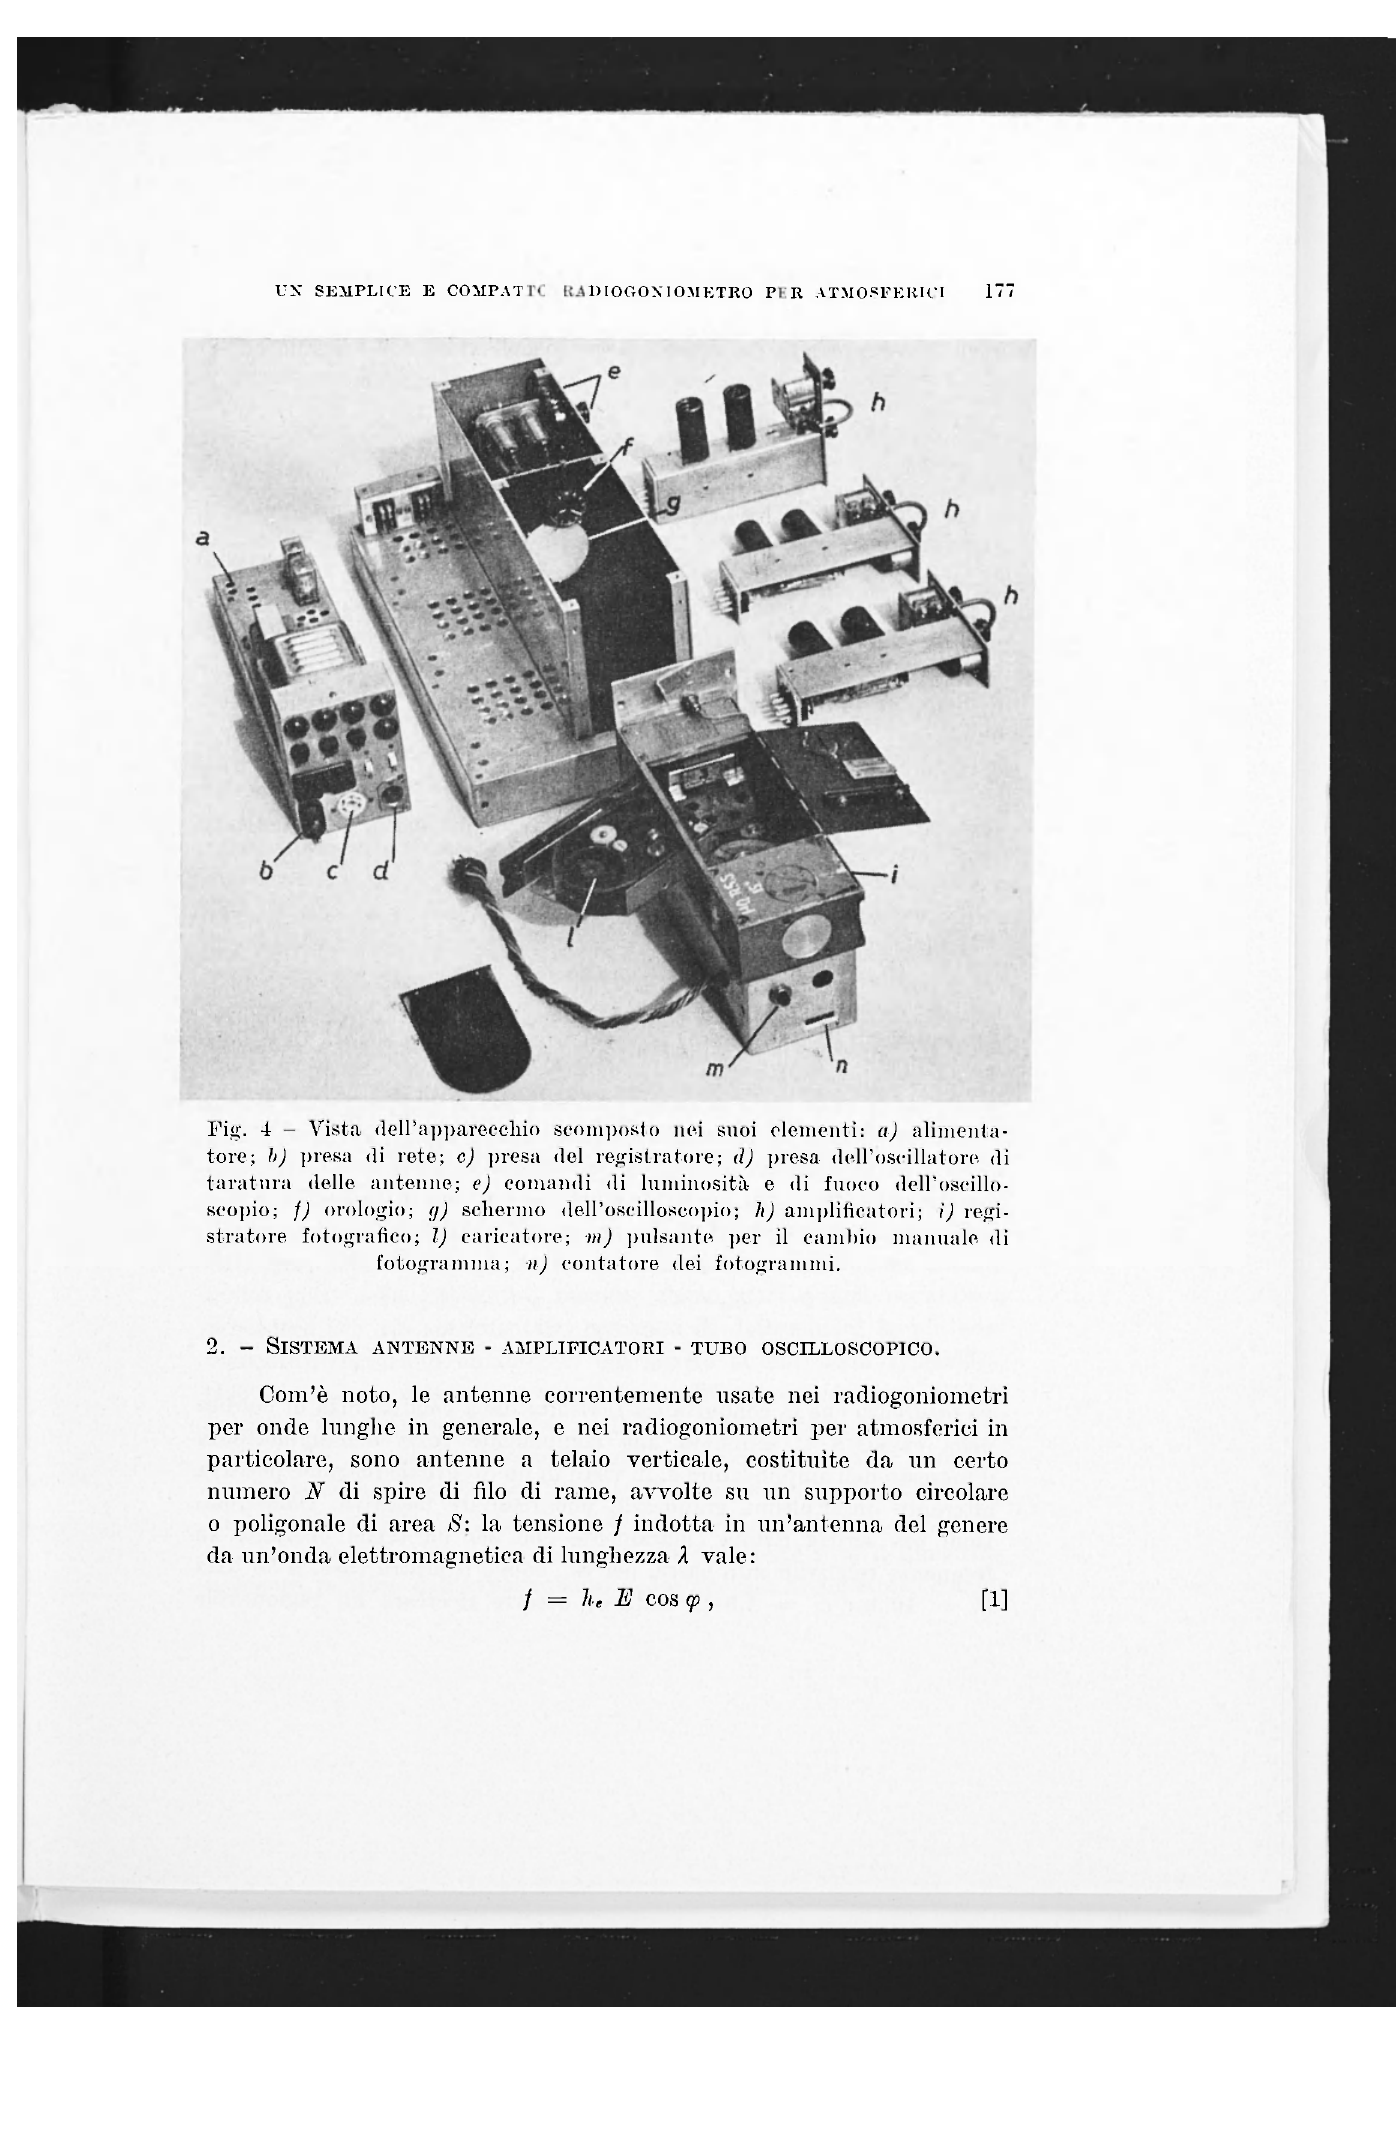
2. - SISTEMA ANTENNE - AMPLIFICATORI - TUBO OSCILLOSCOPICO. Com'è noto, le antenne correntemente usate nei radiogoniometri per onde lunghe in generale, e nei radiogoniometri per atmosferici in particolare, sono antenne a telaio verticale, costituite da un certo numero N di spire di filo di rame, avvolte su un supporto circolare o poligonale di area la tensione / indotta in un'antenna del genere da un'onda elettromagnetica di lunghezza A vale: / = h, E cos cp ,